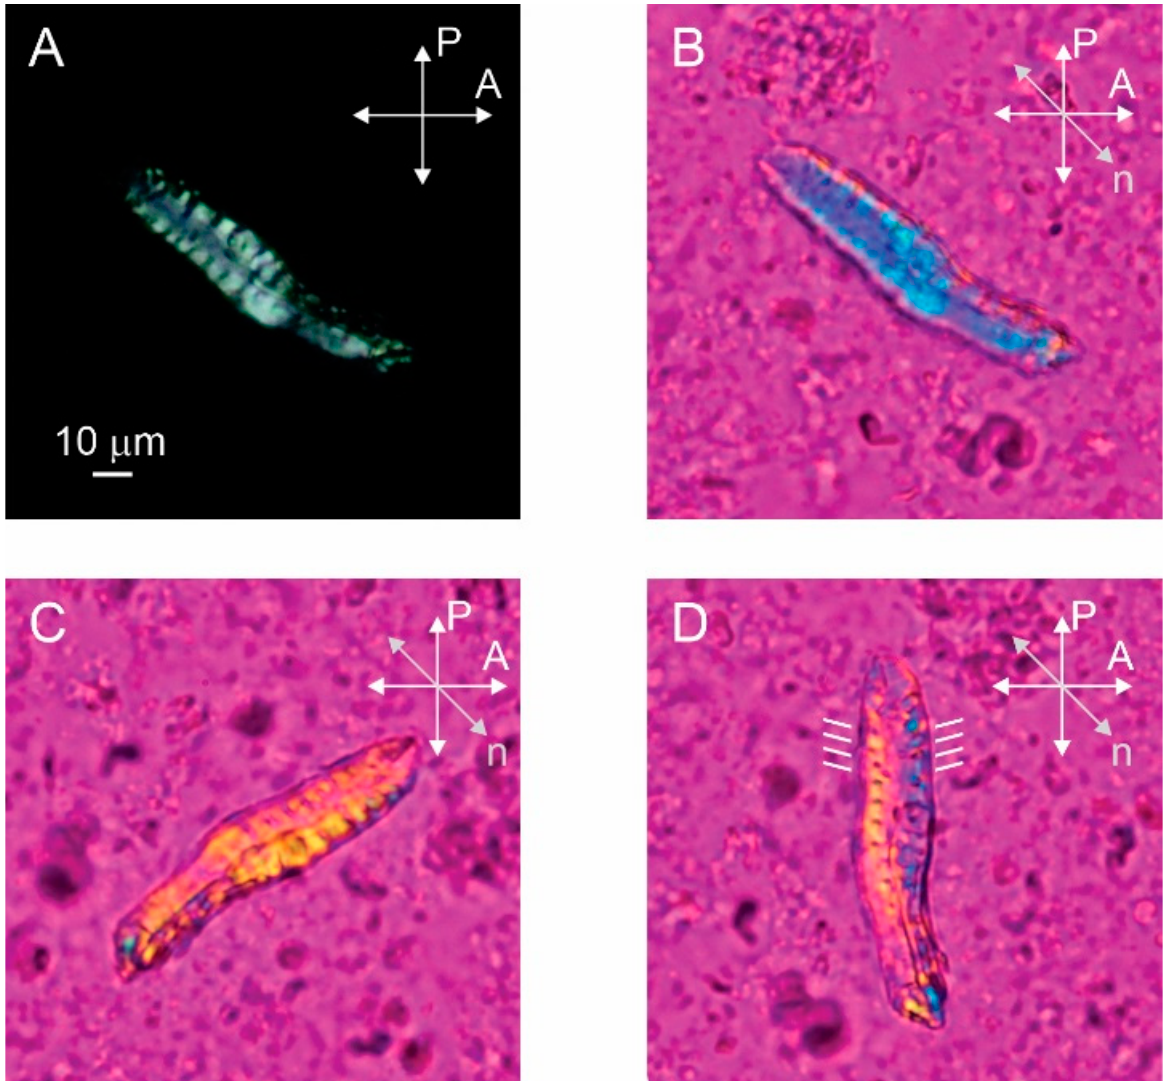
Figure 2. Bundle of stefin B amyloid fibrils prepared at pH 7.5 observed by polarizing optical microscopy. ( A ) Bundle shows birefringence when observed between crossed polarizers. ( B – D ) By inserting the red wave plate retarder and rotating the sample we can determine the direction of optical axis and alignment of fibrils, which is indicated by white lines next to the bundle ( D ). P and A show the orientations of the polarizer and the analyser and n is the direction of the optical axis of the retarder.